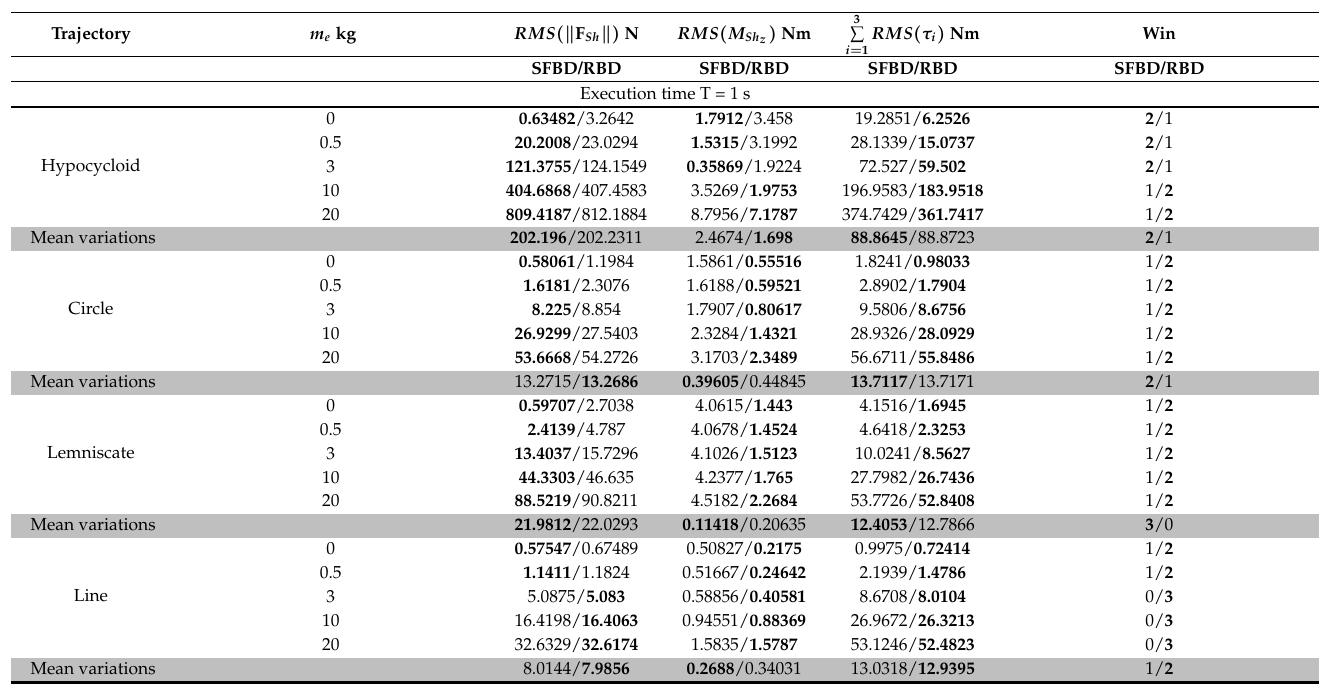
The boldface number indicates the best performance between the design approaches. The shadowed rows “Mean variations” indicate the average of the difference between the RMS value of the indicators with two different masses m e in the end-effector. Table 11. Comparative results of the RBD with respect to the SFBD with different tasks, speeds, and end-effector